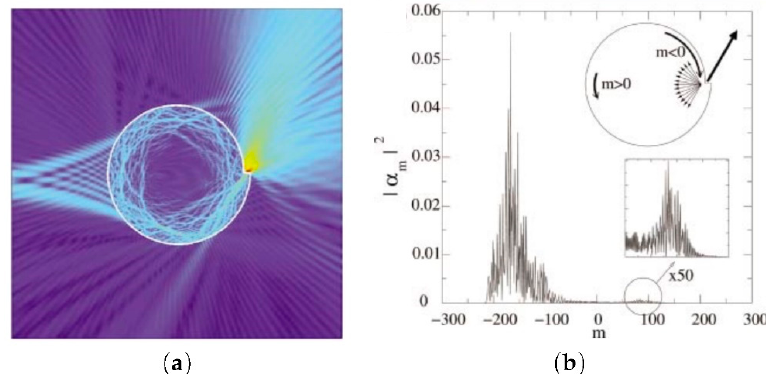
Figure 24. ( a ) real-space plot of the electric field modulus concerning to a calculated quasibound state at nkr 0 ≈ 200 with an eccentricity deformation ( (cid:101) = 0.10); ( b ) angular momenta distribution for the resonance plotted in ( a ). The peak at negative m corresponds to clockwise rotation, and the weak peak at positive m corresponds to counterclockwise rotation; the counterclockwise modes are the diffracted waves emitting from the notch. Reproduced from [213], with the permission of AIP Publishing.